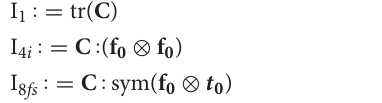
TABLE 1 | The values used for the leaflet morphological parameters.